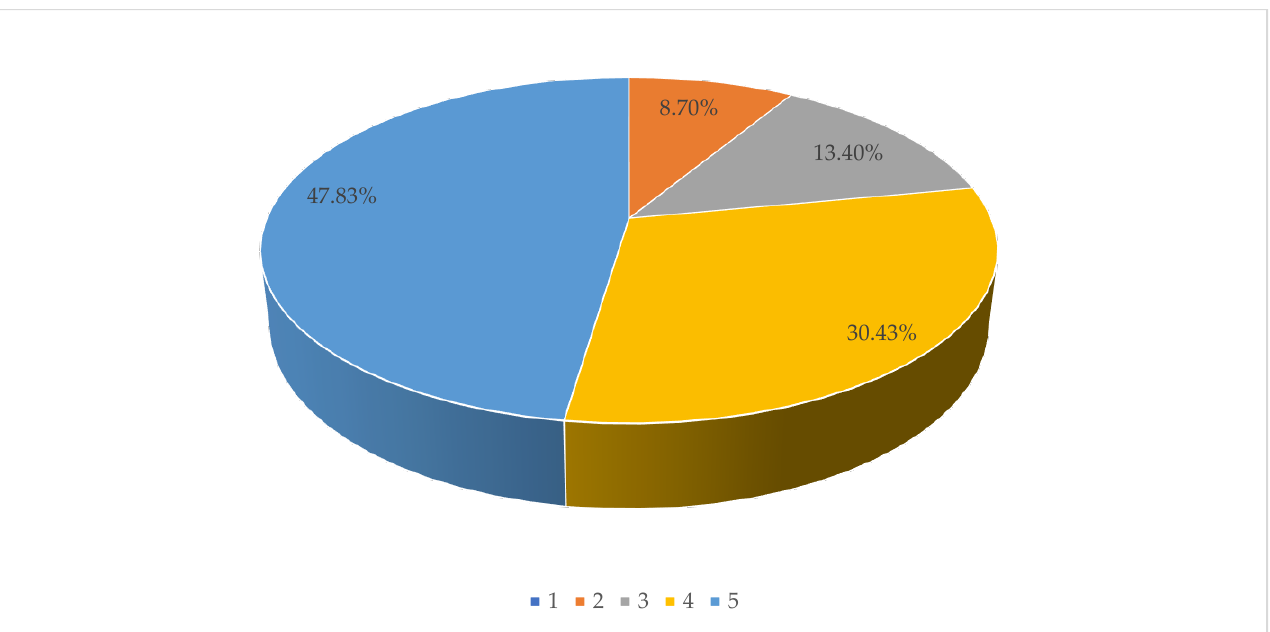
Figure 8. Experts’ own evaluation of knowledge on smart city issues. Source: Own study.